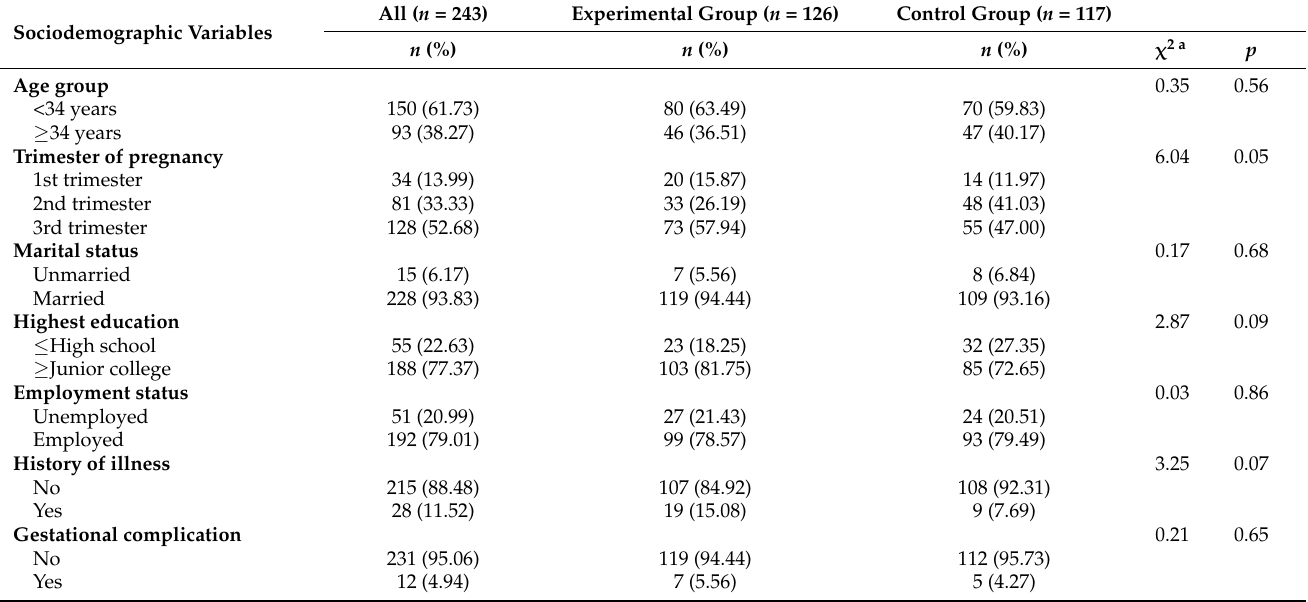
Table 1. Description of sociodemographic characteristics between two groups of pregnant women. Sociodemographic